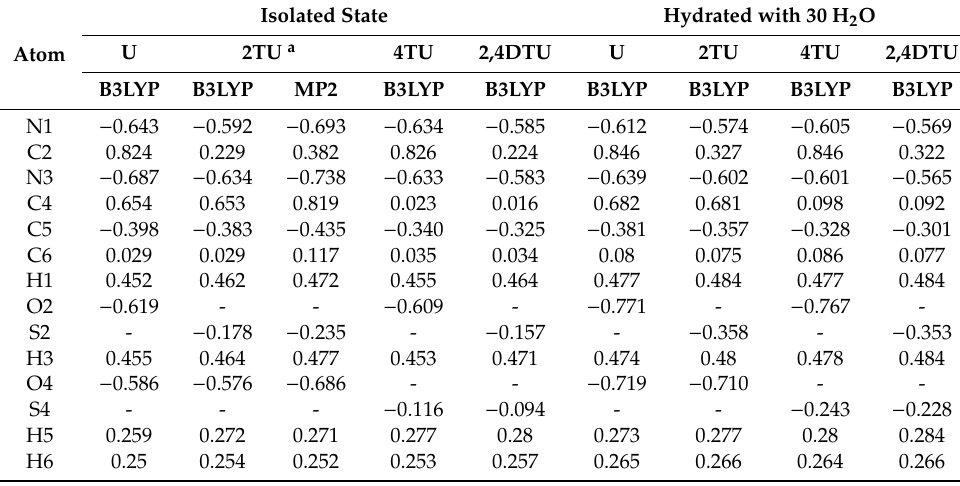
Table 2. Total natural bond orbital (NBO) atomic charges on the atoms in the isolated state and under hydration in the cluster with 30 water molecules of uracil (U), 2-thiouracil (2TU), 4-thiouracil (4TU) and 2,4-dithiouracil (2,4DTU) by MP2 and B3LYP and with the 6-31G(d,p) basis set. Isolated